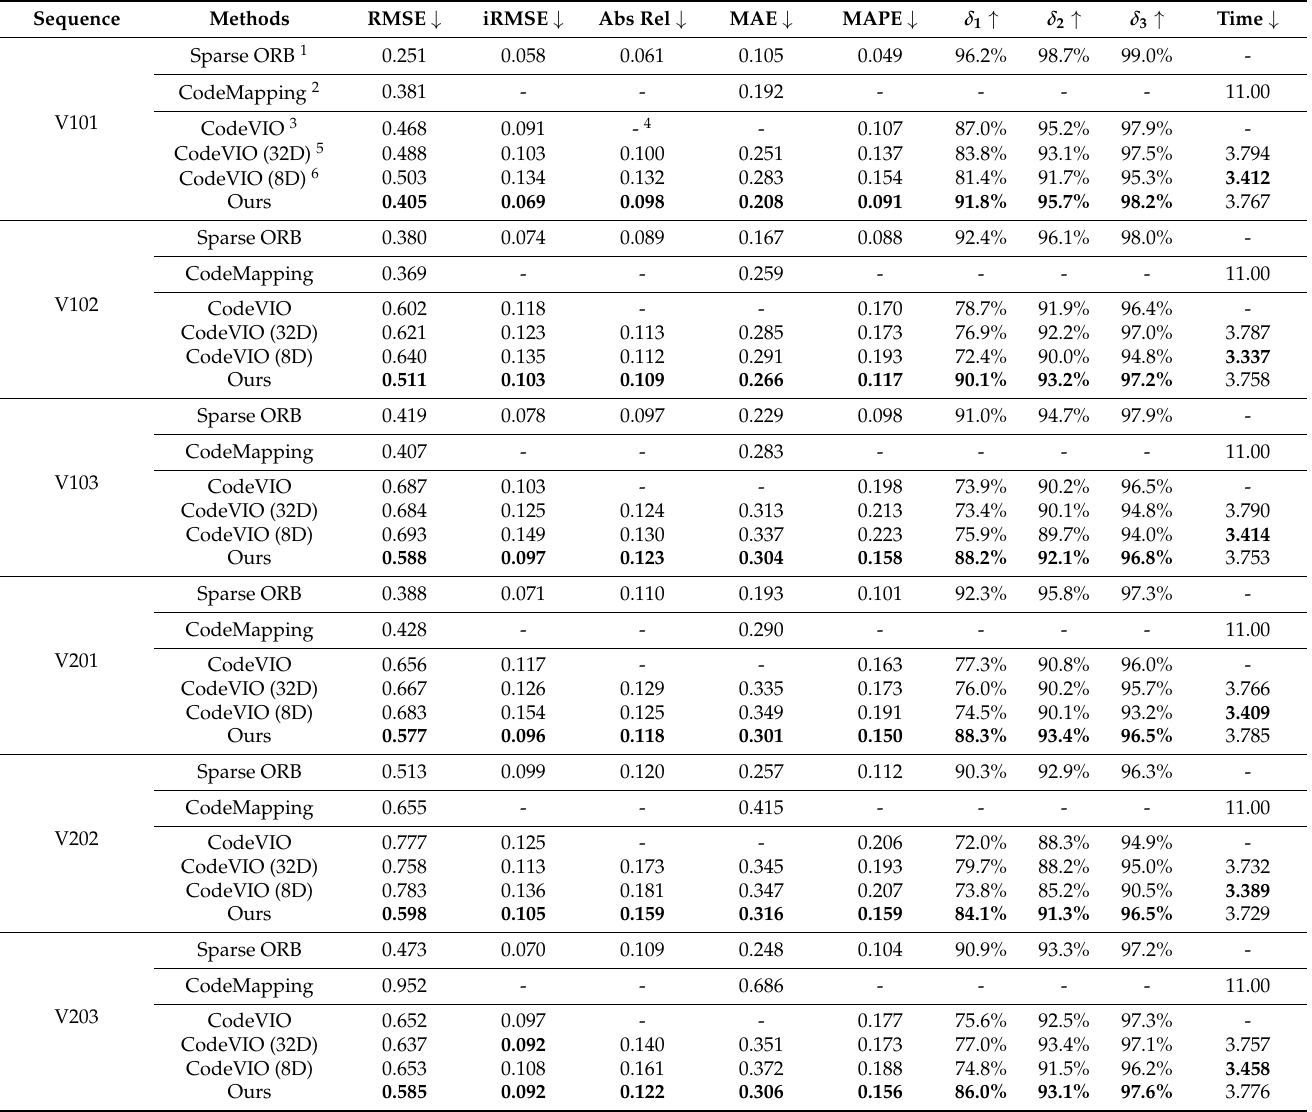
Table 2. Depth evaluation of sparse depth from map points of SLAM (Sparse ORB) and light-weight dense depth estimation methods in the Gray + Sparse Depth modality on the 6 Vicon room sequences of EuRoC dataset. The best is shown in